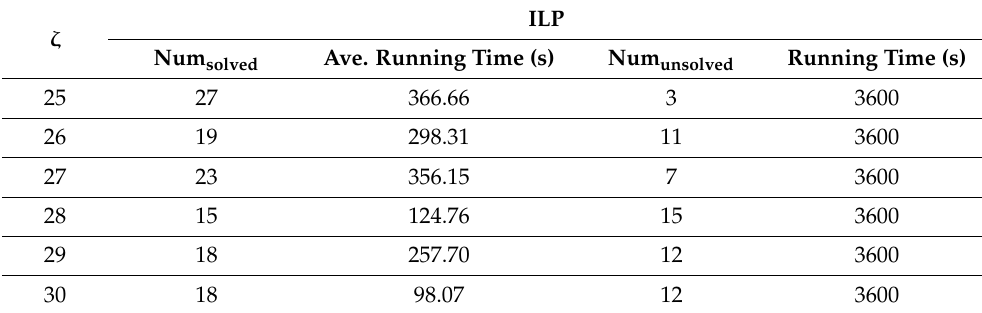
Table 2. Experimental results for problems with ζ ∈ [25, 30].